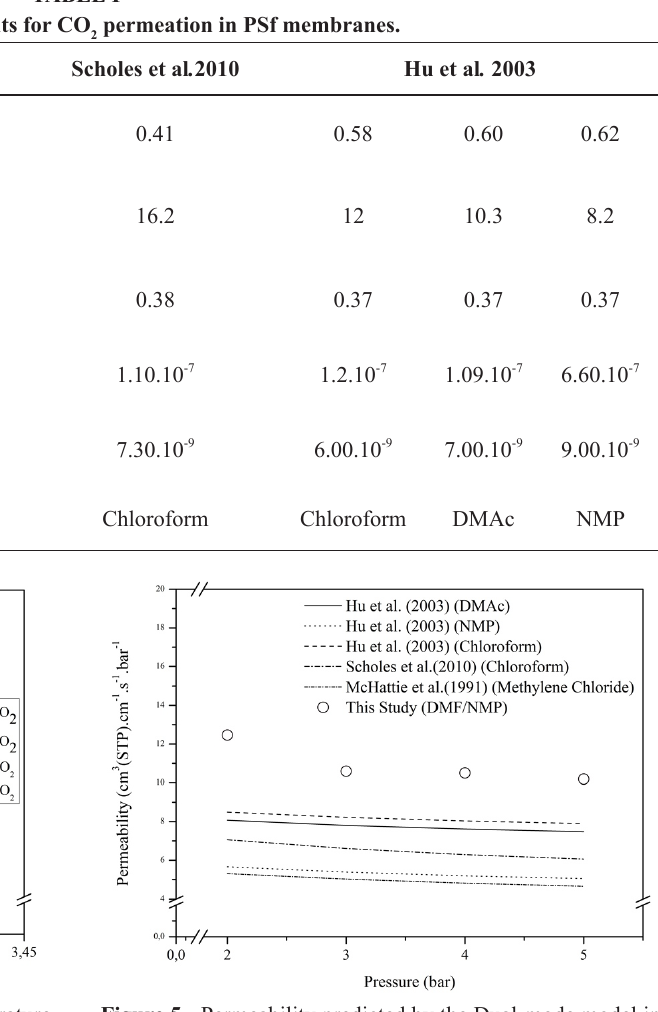
Figure 4 - Membrane permeability of CO function under varying feed pressures.